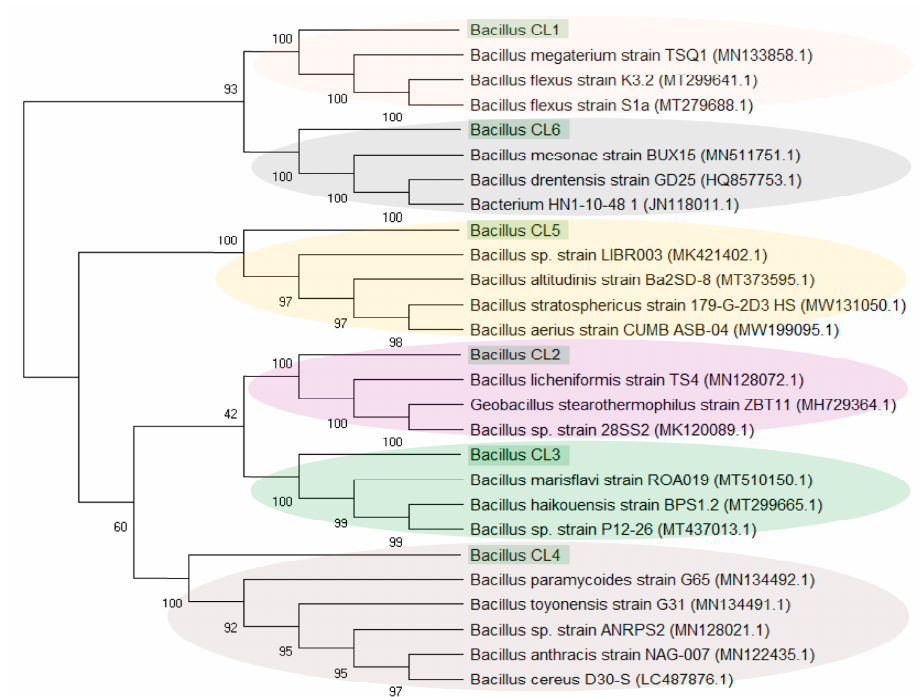
Figure 6. Evolutionary relationships of Bacillus clusters, where the numbers above the branches indicate the bootstrap value. Phylogenetic tree determined by the Neighbour-joining method using MEGA-X software. The clades are marked with colours.